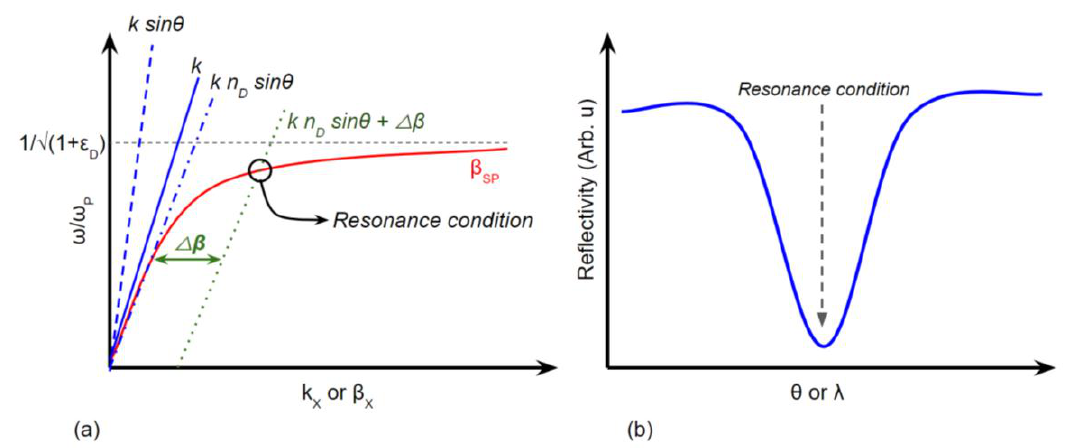
Figure 2. ( a ) Dispersion relation of grating coupler-based SP excitation. ( b ) Reflectivity profile of light due to SPR absorption.